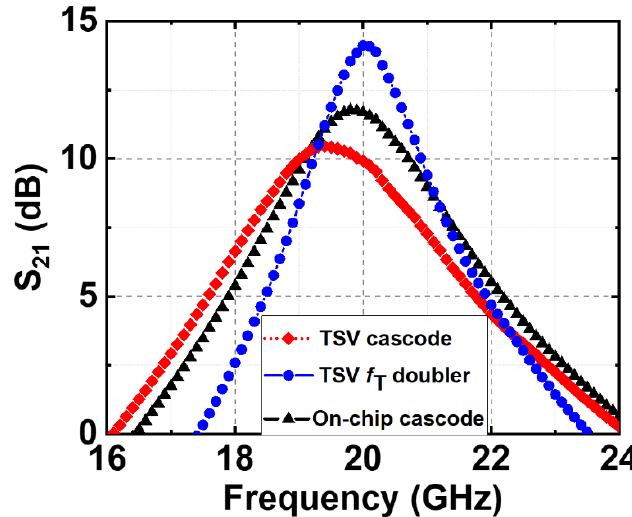
Figure 5. Comparison gain (S 21 ) between the on-chip RFAs and TSV-integrated RFAs.